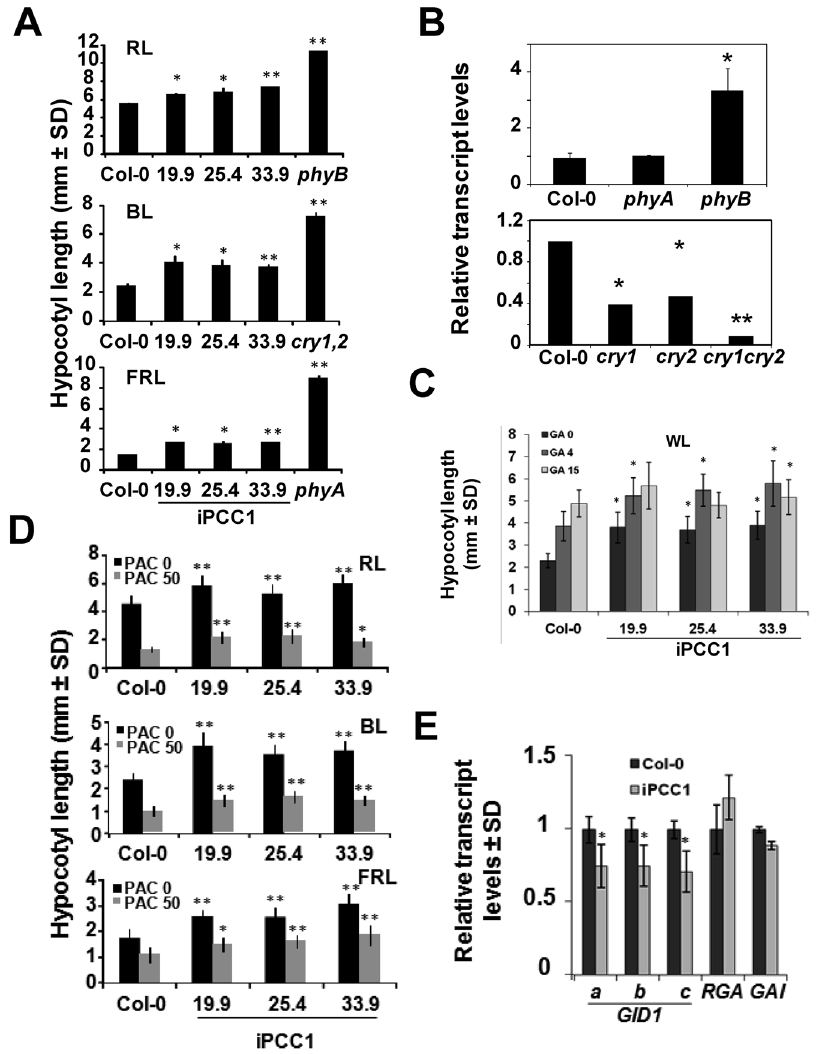
Figure 6. Light- and gibberellin-related hypocotyl phenotypes of iPCC1 plants. Hypocotyl length of seedlings grown under (A) 10 m mole m 2 2 s 2 1 of red light (RL), 30 m mole m 2 2 s 2 1 of blue light (BL), or 5 m mole m 2 2 s 2 1 of far-red light (FRL) for 4 days, and (D) the same light conditions as in (A) but treated as indicated with the gibberellin synthesis inhibitor paclobutrazol (PAC). (B) PCC1 transcript levels were quantified by qRT-PCR in wild type Col-0 and the indicated photoreceptor mutant seedlings. Values are the mean of three independent biological replicates 6 SD and are expressed as relative levels to those detected in wild type seedlings. (C) Hypocotyl length of seedlings grown under 60 m mole m 2 2 s 2 1 of white light (WL), with the indicated m M concentrations of GA3 (GA). Values are the mean of 20 hypocotyls per genotype and condition 6 SD. * and ** represents statistically significant (p , 0.05 or p , 0.01, respectively, in Students t-test) different values in iPCC1 seedlings when compared to wild type seedlings under the same condition. (E) Transcript levels of the indicated genes involved in the perception and signaling of gibberellins were analyzed by qRT- PCR in Col-0 and iPCC1 seedlings grown under 16 h light/8 h darkness photoperiodic white light conditions for 14 days. Values are the mean of three independent biological replicates 6 SD and are expressed as relative levels to those detected in wild type seedlings. * represents statistically significant (p , 0.05 in Students t-test) different values in iPCC1 seedlings when compared to wild type seedlings.